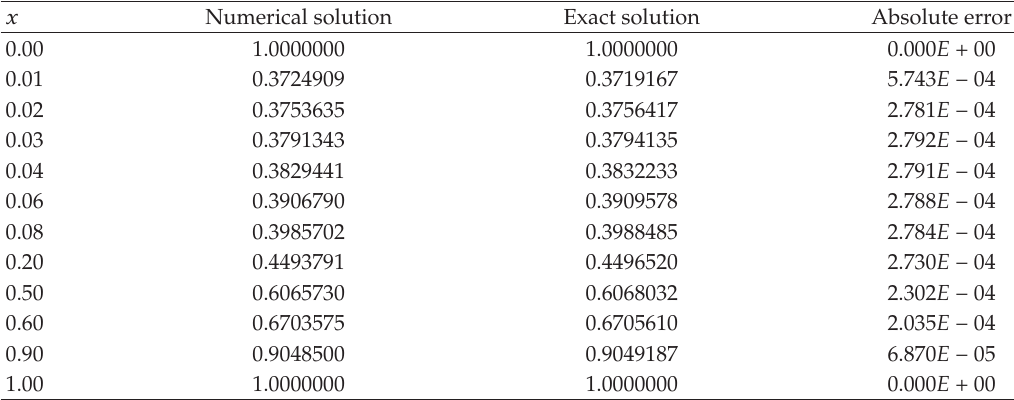
Table 1: Numerical results of Example 4.1 for ε (cid:8) 0 . 001 , δ (cid:8) 0 . 0001, N (cid:8) 100.